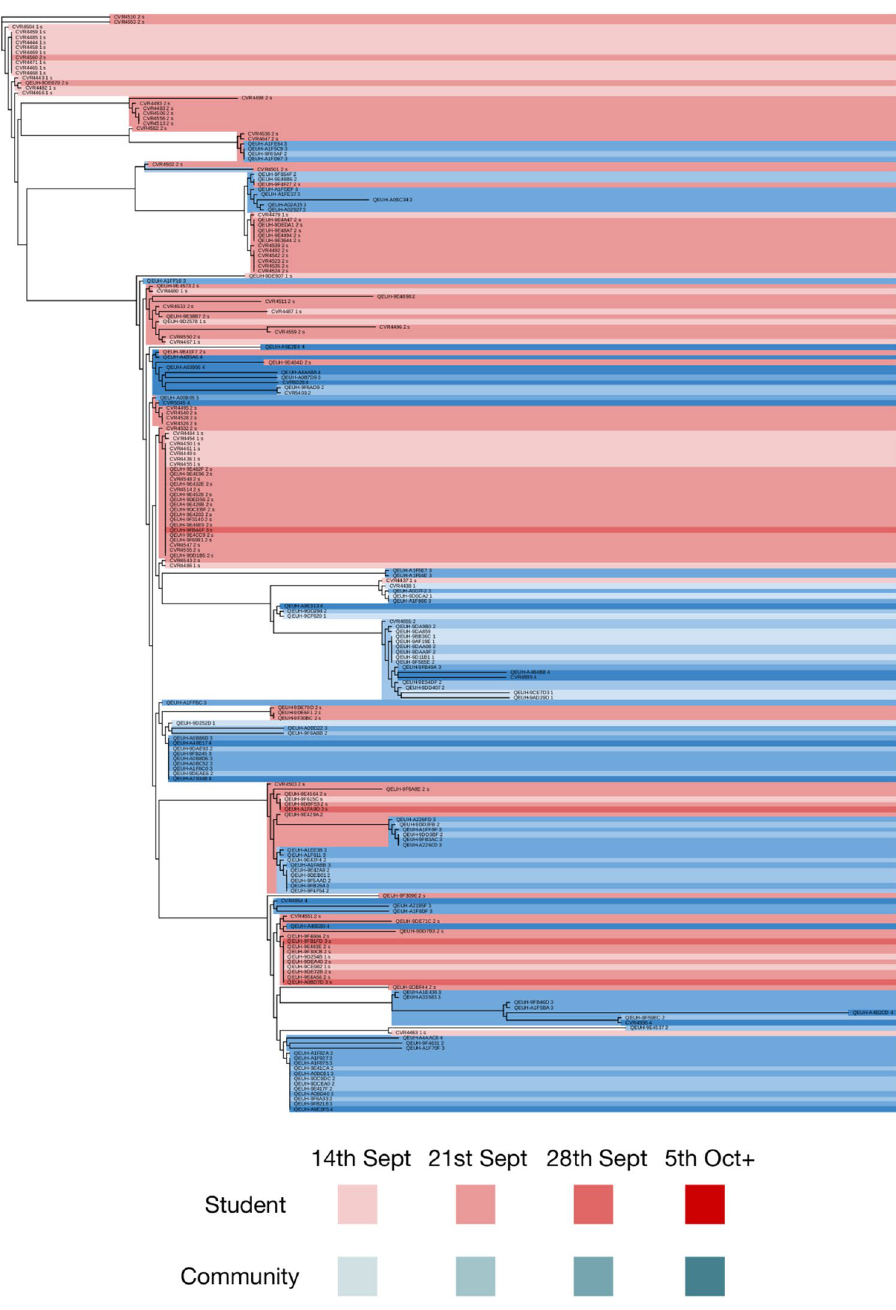
Figure 5. Phylogenetic relationship between student (red) and community (blue) sequences associated with transmission clade 1. Shades indicate the week in which sequences were collected, the lightest colour indicating dates before and including the week of 14th September, and the darkest colour indicating dates from the 5th October onwards. Community sequences describe those identified in NHS Greater Glasgow and Clyde sharing a common ancestor with the student sequences. Student and community cases were observed in multiple subclades of the tree, indicating ongoing transmission between the students and local community. Phylogenetic analysis was conducted using iQ-Tree2 38 , while the figure was made with iTOL 44